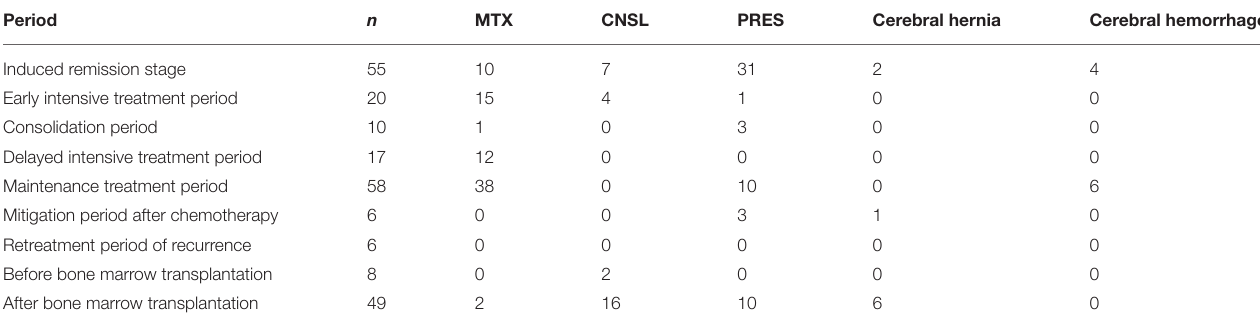
TABLE 3 | Etiology diagnosis of primary epilepsy seizures.